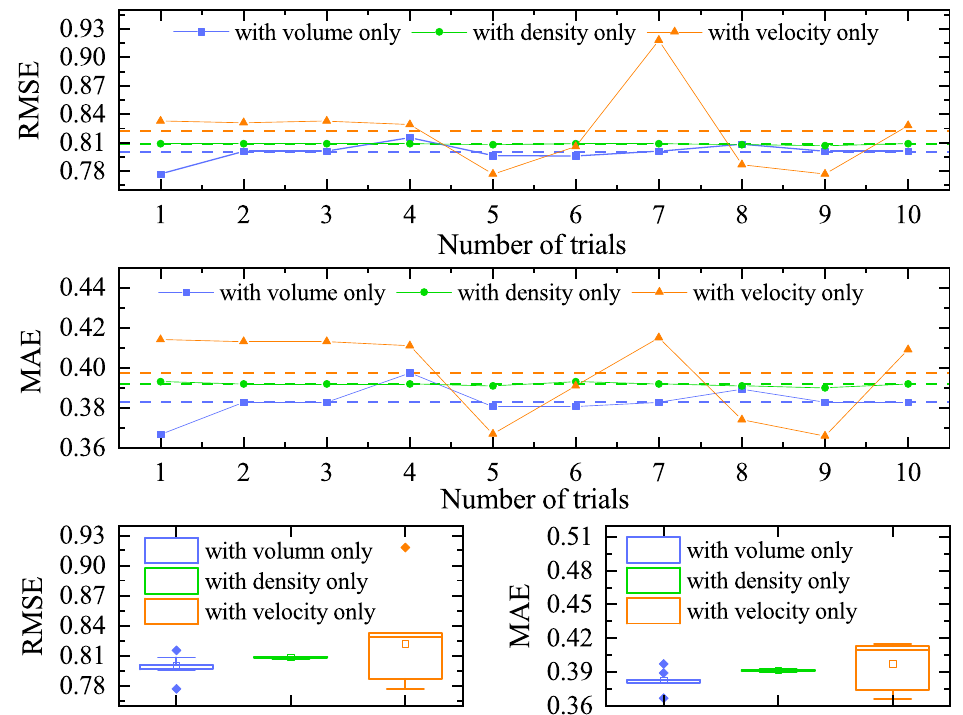
Figure 12. Performance of LSTM models with single traffic